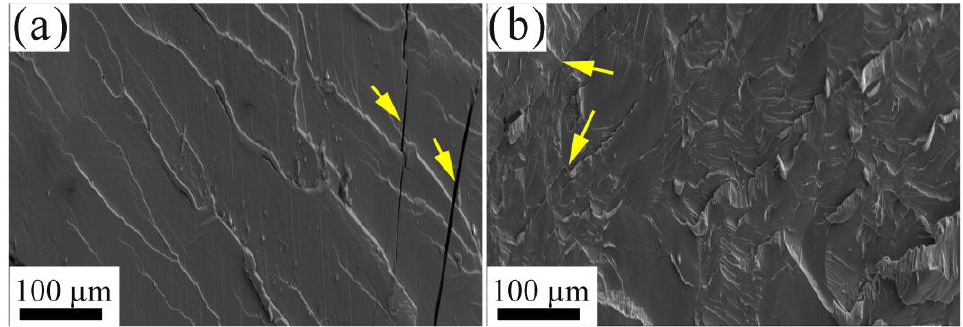
Figure 6. SEM images of fracture surfaces of: ( a ) Al 0.3 CrFeNiV; and ( b ) Al 0.5 CrFeNiV alloys following the compression deformation at room temperature; the yellow arrows indicate the microcracks.